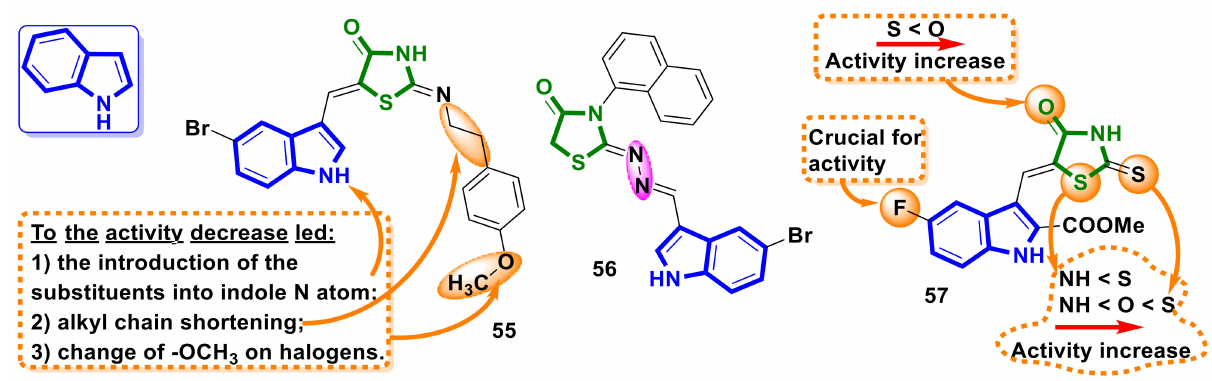
Figure 22. The structures of indole-bearing hybrids molecules with 4-thiazolidinone scaffolds as antimitotic